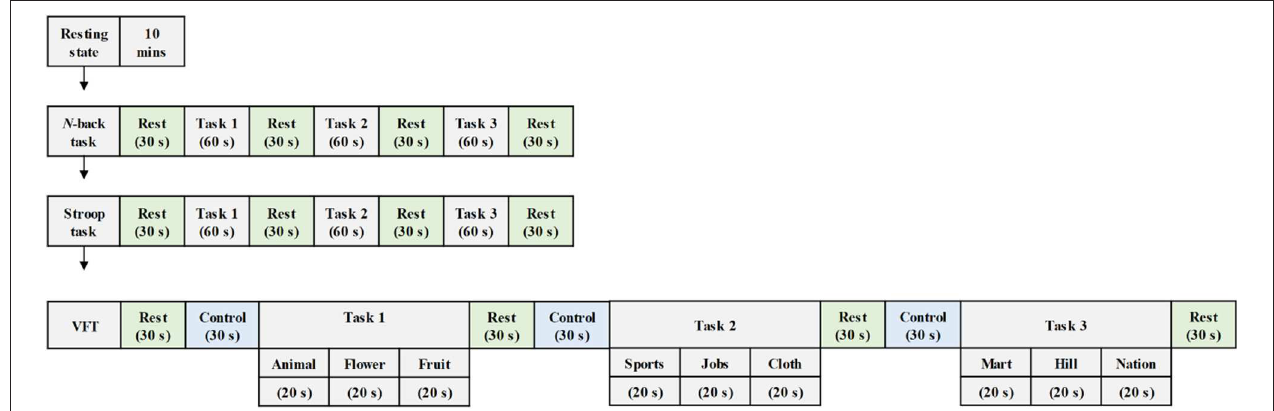
FIGURE 2 | Experiment paradigm for various mental tasks (i.e., N -back task, Stroop task, and verbal fluency task) during the examination.